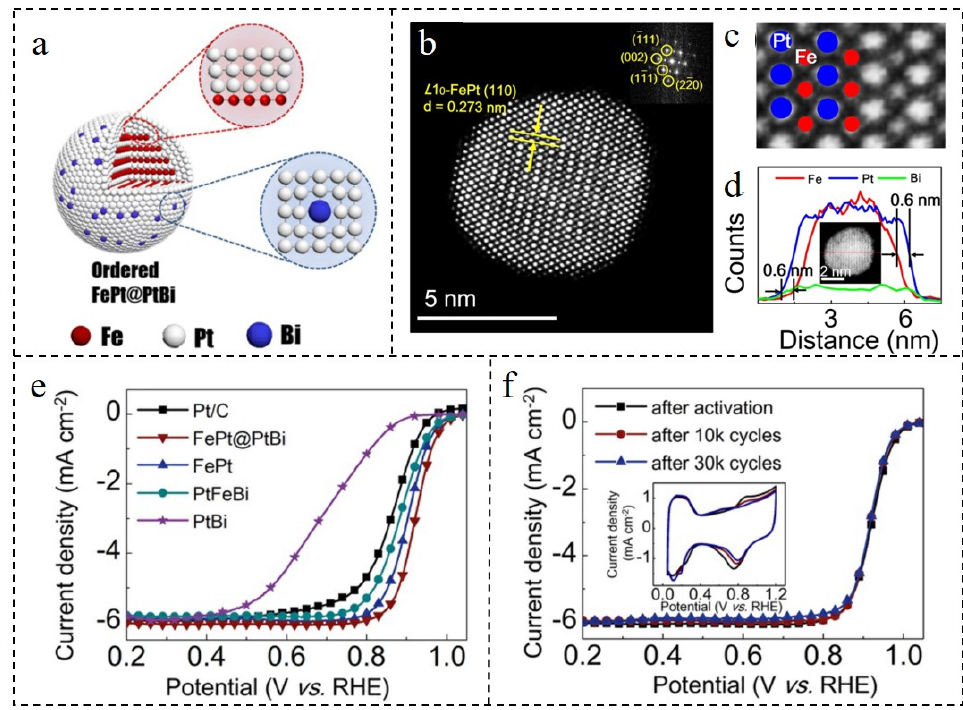
Figure 8. ( a ) The structure diagram of FePt@PtBi. HAADF-STEM images of ( b ) FePt@PtBi and ( c ) FePt core. ( d ) EDS line-scanning of FePt@PtBi. ( e ) LSV curves (5 mV·s − 1 ) of FePt@PtBi, FePt, PtFeBi, PtBi and Pt/C in O 2 -saturated 0.1 M HClO 4 solution. ( f ) LSV curves (100 mV·s − 1 ) of FePt@PtBi in N 2 -saturated 0.1 M HClO 4 solution before and after the multiple cycles, and the corresponding CV curves. Reproduced with permission from [102]. Copyright © 2022, Wiley-VCH.